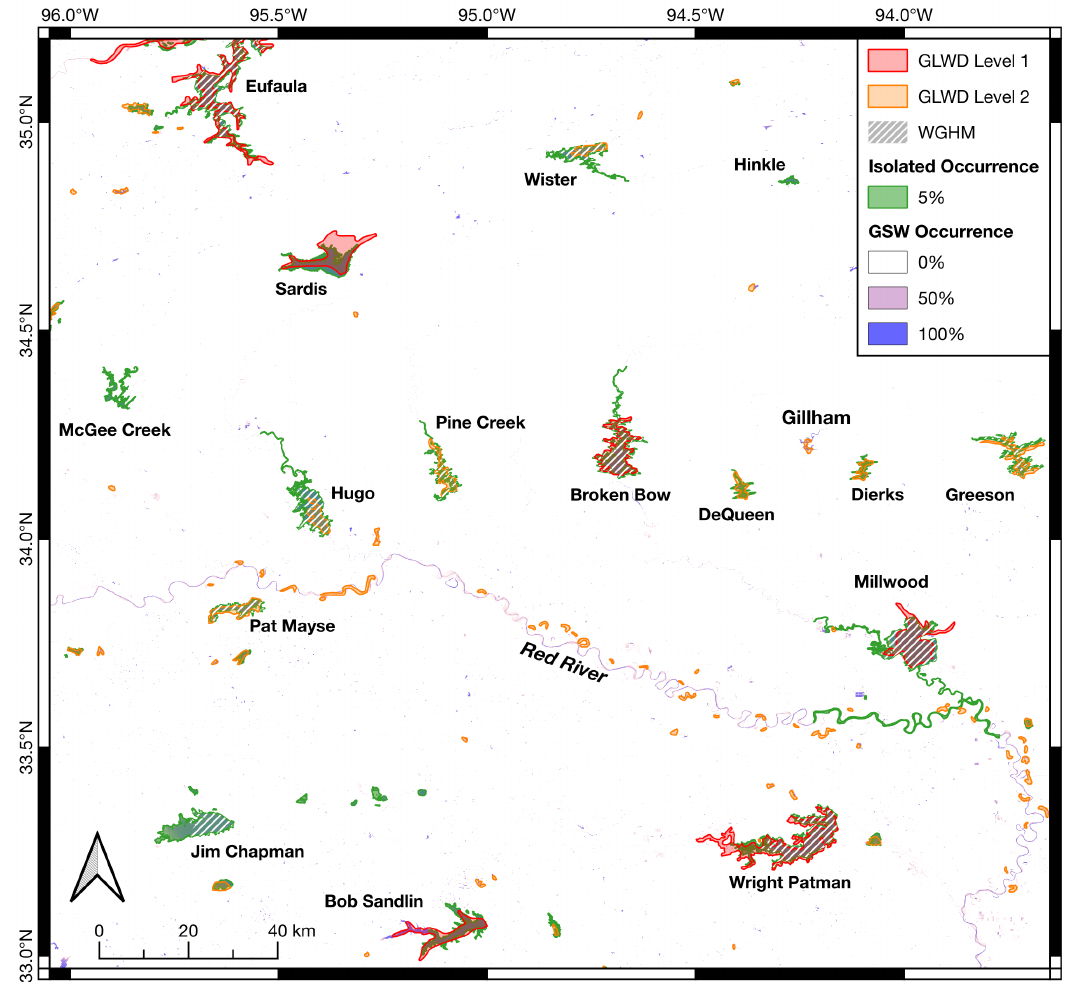
Figure 6. Isolated occurrence of detected targets (green), GLWD Level 1 (red) and 2 (orange) and WGHM data (white hatched) surrounding the Red River at the border between Arkansas and Oklahoma. Additionally, the GSW water occurrence is shown as